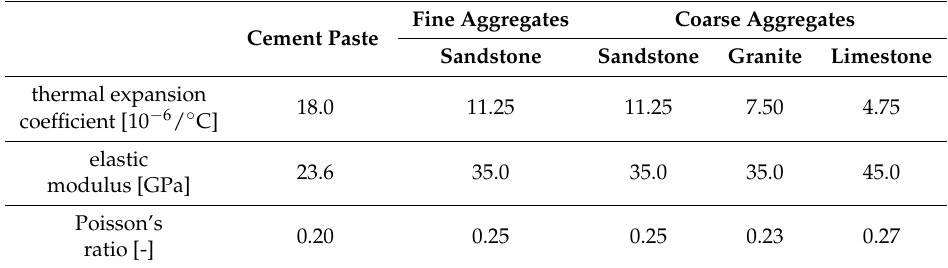
Table 9. Input for sensitivity analysis: thermal expansion coefficient and elastic parameters of the cement paste, the fine aggregates and the coarse aggregates.